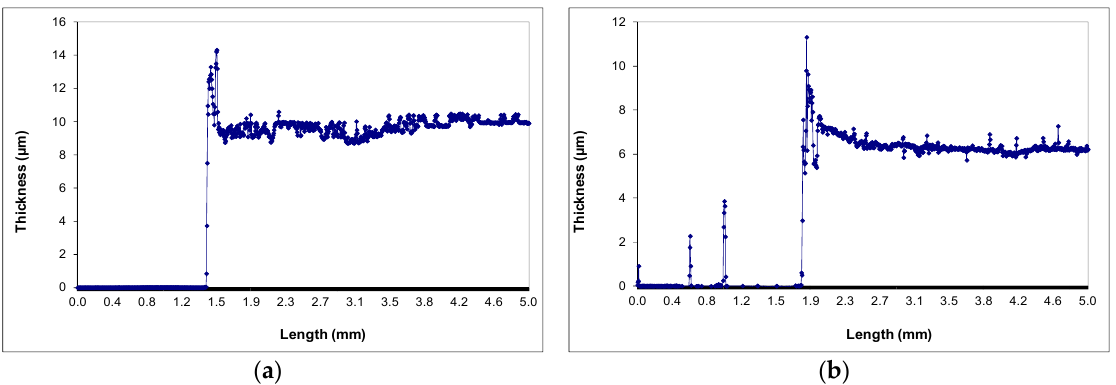
Figure 2. Morphology and thickness of nanowire based films: ( a ) ZnO nanoparticle film; and ( b ) ZnO nanowire film.